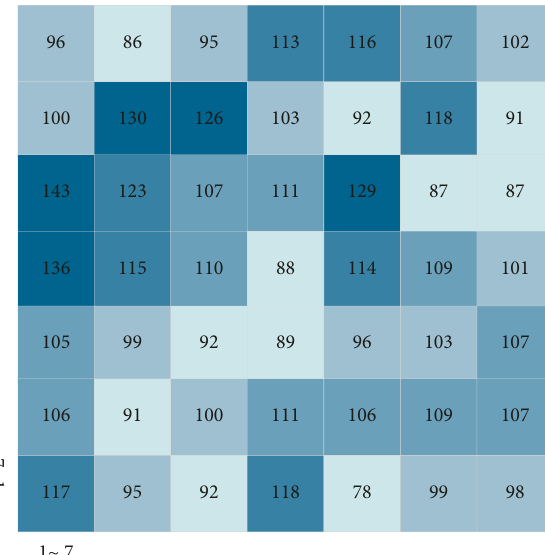
Figure 13: Statistical results of congestion frequency of each grid.